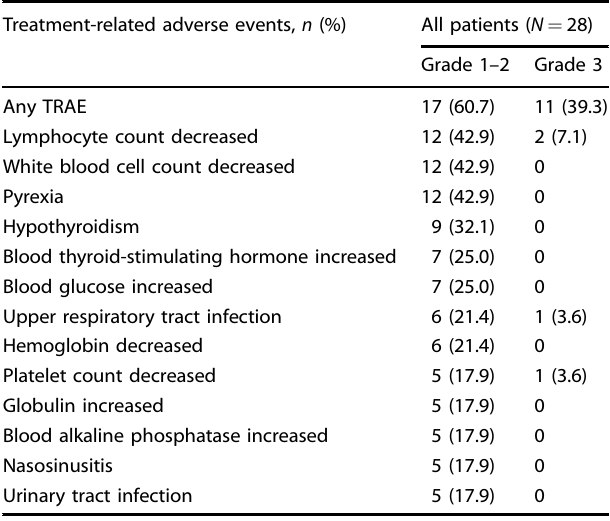
The patients were evaluated for ef fi cacy using 18 FDG-PET at baseline and weeks 6, 15, and 24. Contrast-enhanced computed tomography was used at baseline and weeks 24, 36, and 48 and every 24 weeks thereafter. Ef fi cacy was assessed according to the Lugano 2014 standard. 31 The best overall response was the best response recorded from the start of the study until progression/ relapse. Safety was monitored throughout the study until 90 days after the last dose of sintilimab. The quality of life was analyzed at the initial dose, at weeks 6, 15, 24, 36, and 48, and every 24 weeks